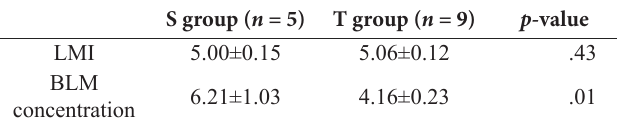
Table 1. Means values of BLM concentrations (mmol.L -1 ) and exer- cise loads (mmol.L -1 ) obtained by LACmin after the experimental test3 period in both groups (S group n = 5 and T group n = 9) (mean±SD; values with p < .05 indicate significance; Student t- test unpaired).